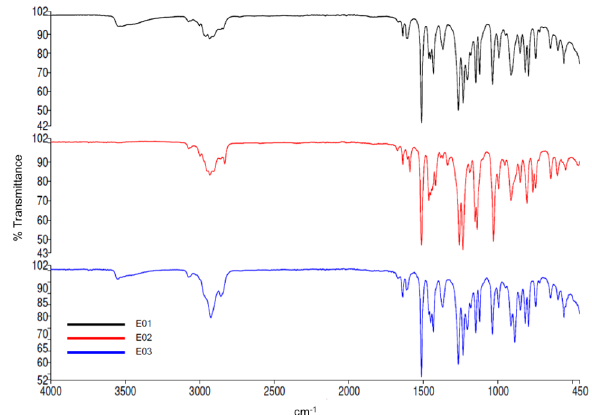
Figure 3. FT-IR spectrum of the essential oil from O. gratissimum (EO1, Black), O. tenuiflorum (EO2, Red), and O. sanctum (EO3, Blue).